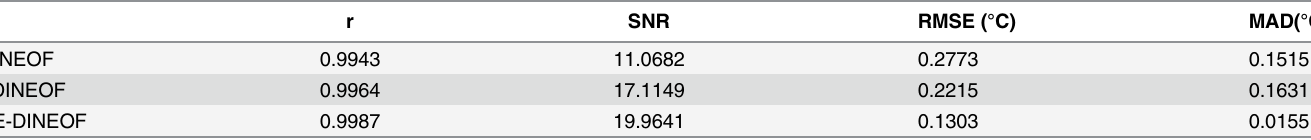
Table 1. Reconstructed results using DINEOF and VE-DINEOF